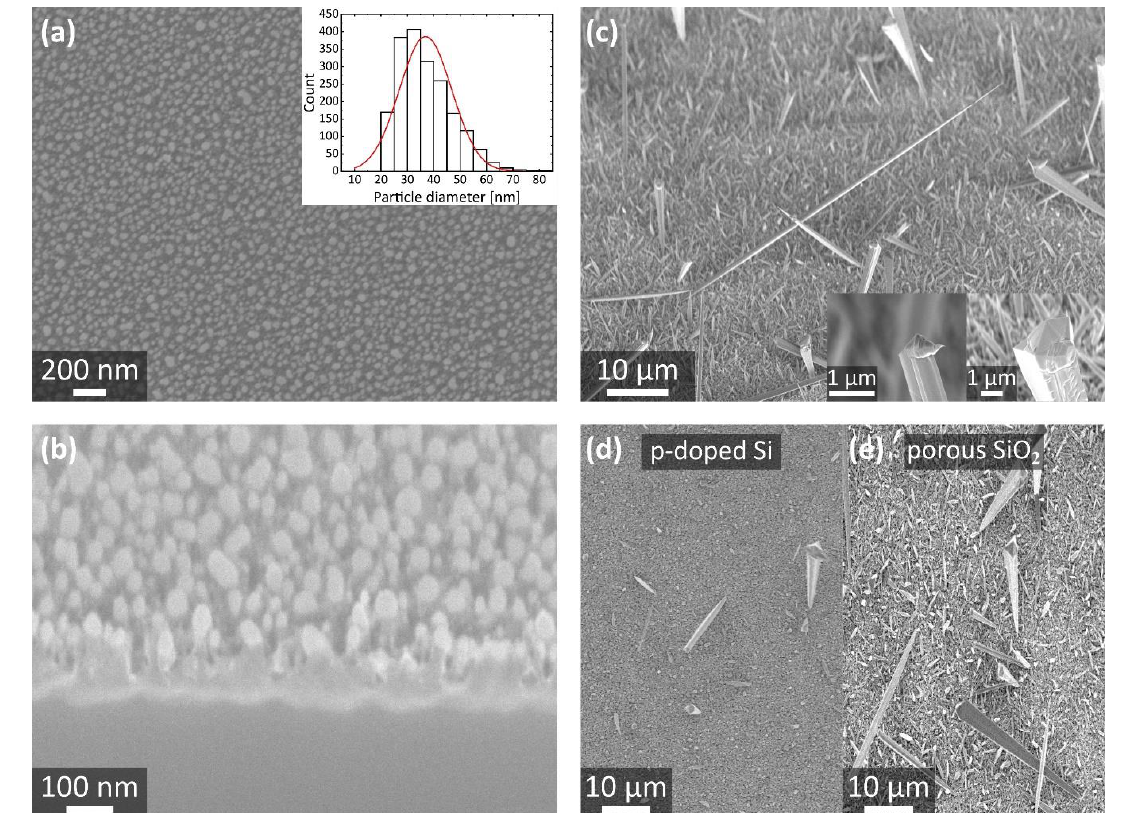
Figure 3. Thermally induced self-assembly of gold particles on porSiO 2 and subsequent catalyst-assisted ZnO NW growth. ( a ) A mean particle diameter of (37 ± 10) nm was found for the densely packed gold dot distribution on the porSiO 2 as presented by the histogram in the inset. ( b ) The gold particles were located on top of the porSiO 2 rather than in the pores, which was revealed by the cross section through the substrate obtained by focused ion beam milling (30 kV, 50 pA). ( c ) The gold particles generated on the porSiO 2 acted as catalysts for the subsequent growth of large, randomly oriented ZnO NWs by MOCVD. Compared to the result on the p-doped Si/native SiO 2 substrate without porSiO 2 ( d ), the ZnO NW growth yield was clearly enhanced on the porSiO 2 layer ( e ). The SEM images in ( a – c , e ) were taken with the Crossbeam 550 by Zeiss. Note, ( b ) and ( c ) were taken at an angle of 54°. The SEM image in ( d ) was taken with the Supra 55 by Zeiss.